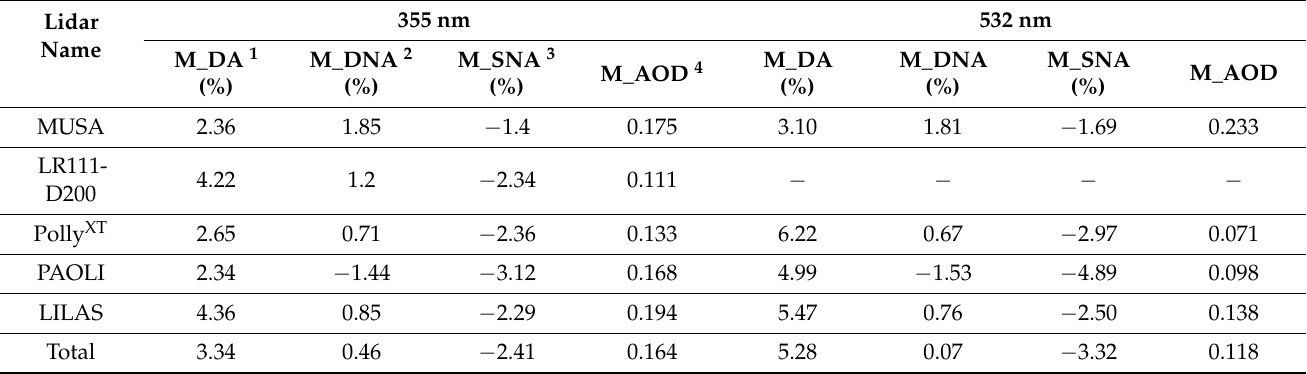
Table 4. The mean value of the mean relative deviation of extinction and mean relative deviation of molecular number density and the mean relative deviation of the gradient in molecular number density and mean aerosol load at 355 and 532